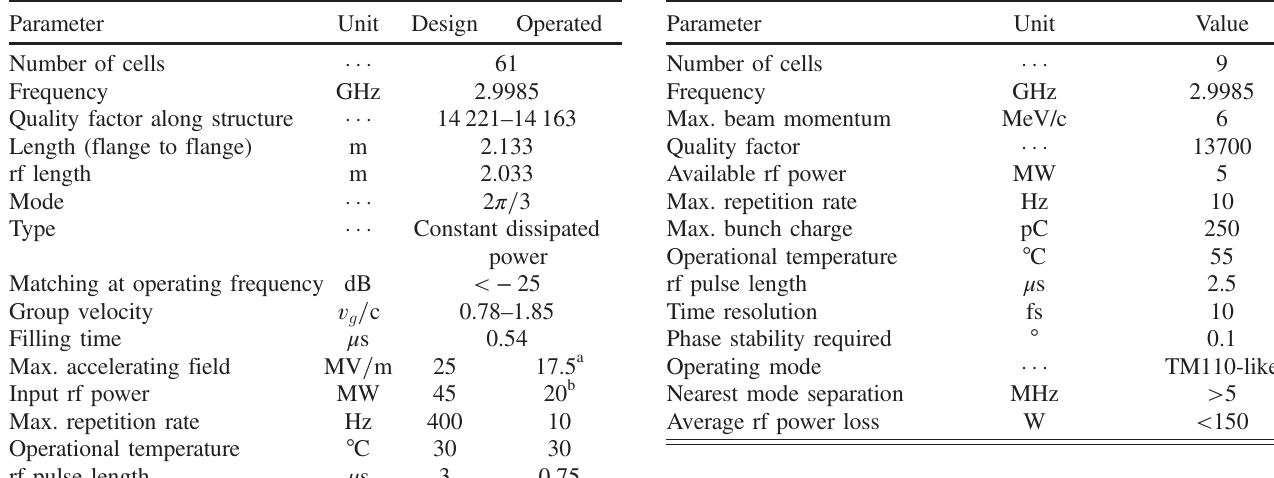
TABLE V. Design and operational parameters of linac 1.